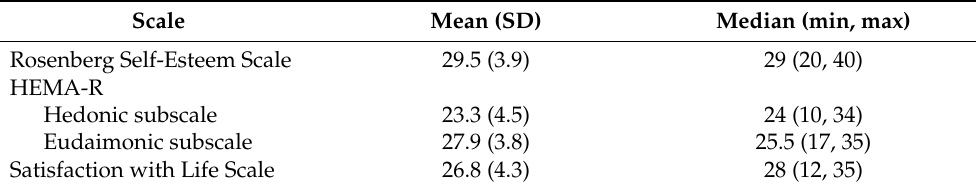
Table 2. Descriptive statistics for the scores of the Rosenberg Self-Esteem Scale, Hedonic and Eudai- monic Motives for Activities-Revised scale, and Satisfaction with Life